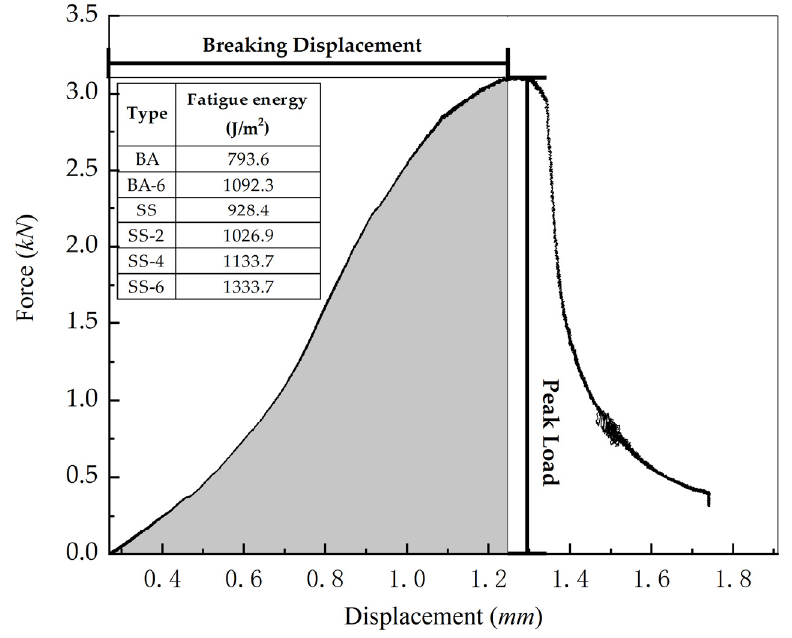
Figure 10 Displacement-Force curve of different asphalt concrete.